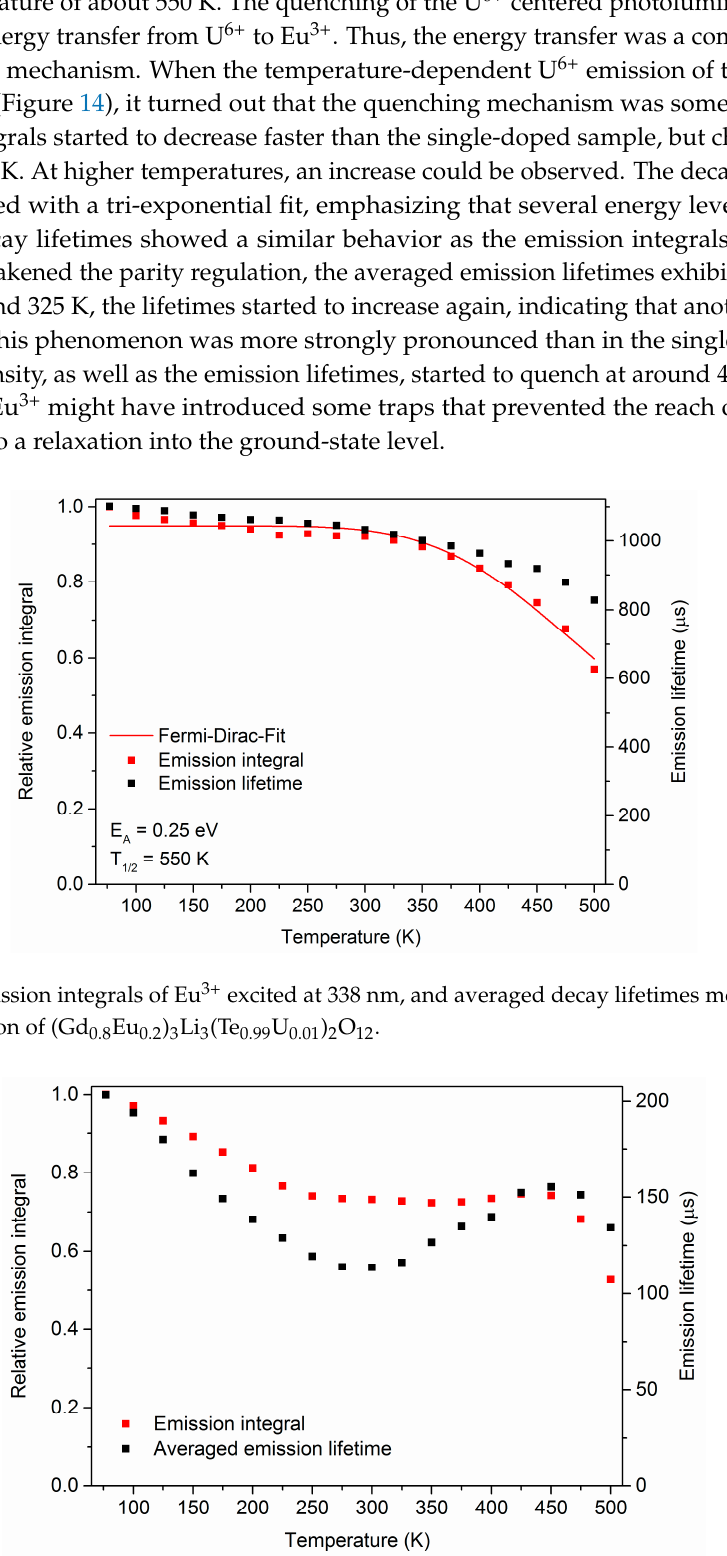
Figure 14. Emission integrals of U 6+ excited at 338 nm, and averaged decay lifetimes monitoring the 550 nm emission of (Gd 0.8 Eu 0.2 ) 3 Li 3 (Te 0.99 U 0.01 ) 2 O 12 .